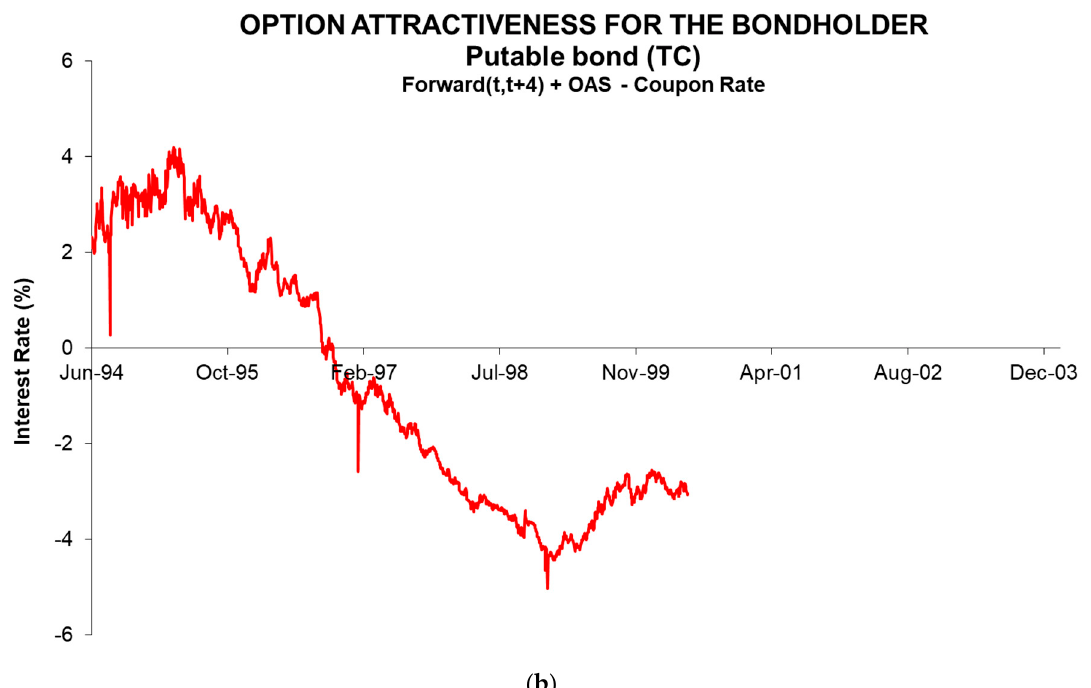
Figure 2. Evolution of the option attractiveness for the bondholder. ( a ) shows the results for the Callable bond (BCL) and ( b ) for the Putable bond (TC).